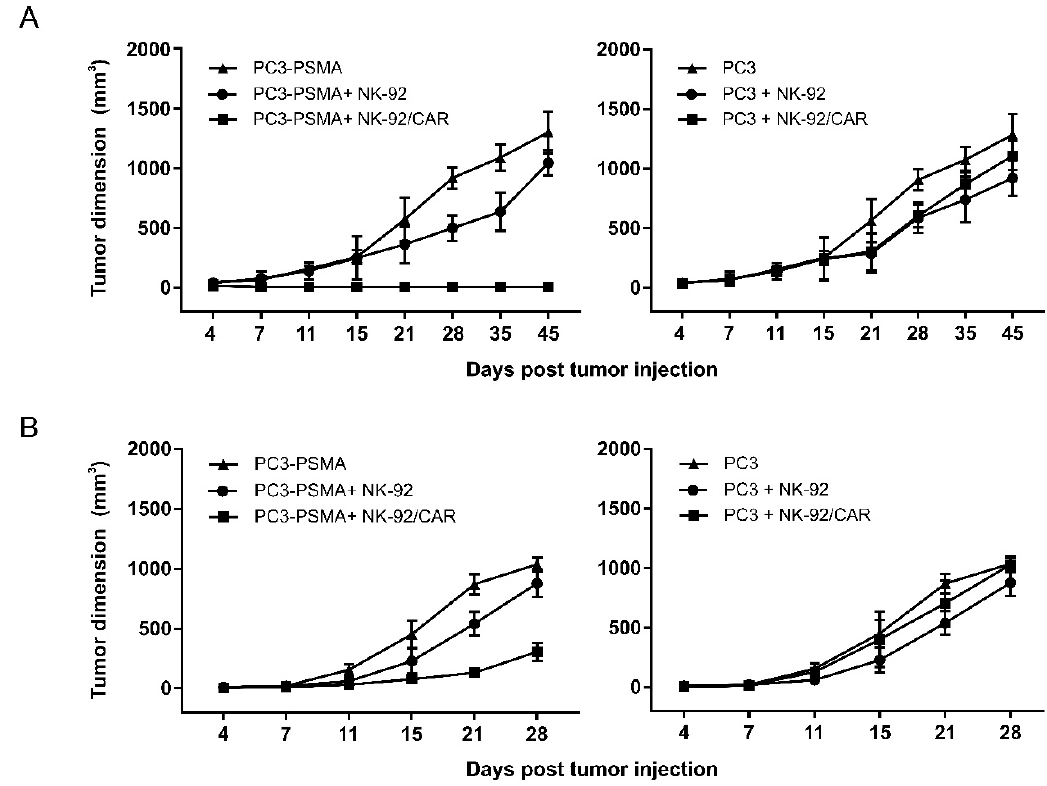
Figure 5. Assessment of NK-92/CAR cells’ in vivo therapeutic efficacy against locally implanted prostate cancers. ( A ) Winn assay. PC3-PSMA (left panel) and PC3 (right panel) cancer cells were inoculated s.c. in NSG (NOD/SCID common γ chain knockout) mice alone (filled triangles), or mixed with NK-92/CAR (filled squares) or parental NK-92 (filled circles) cells. Tumor growth was monitored over time by caliper measurement (6 mice/group). ( B ) Therapeutic activity against established tumors. NK-92/CAR cells or untransduced counterparts were administered i.v. in NSG mice for 3 times at alternate days, starting 4 days after s.c. injection of PC3-PSMA (left panel) or PC3 (right panel) tumor cells. Untreated animals served as control group. Symbols and groups as in a. Data are reported as mean values ± SD of tumor volumes at different time points.